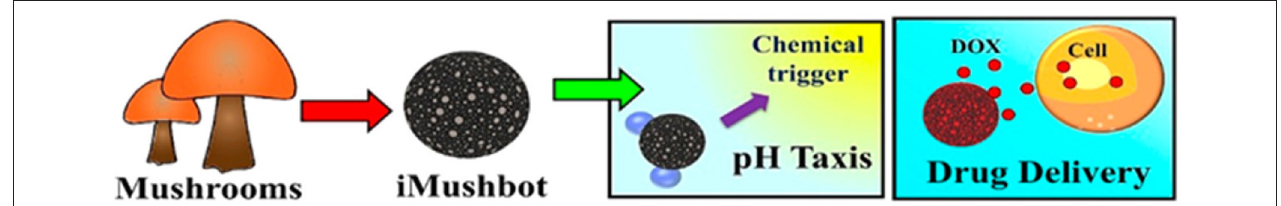
FIGURE 2 | Schematic representation of the iMushbot action (Bhuyan et al., 2017). It is being reproduced with the permission of the copyright holder [American Chemical Society].